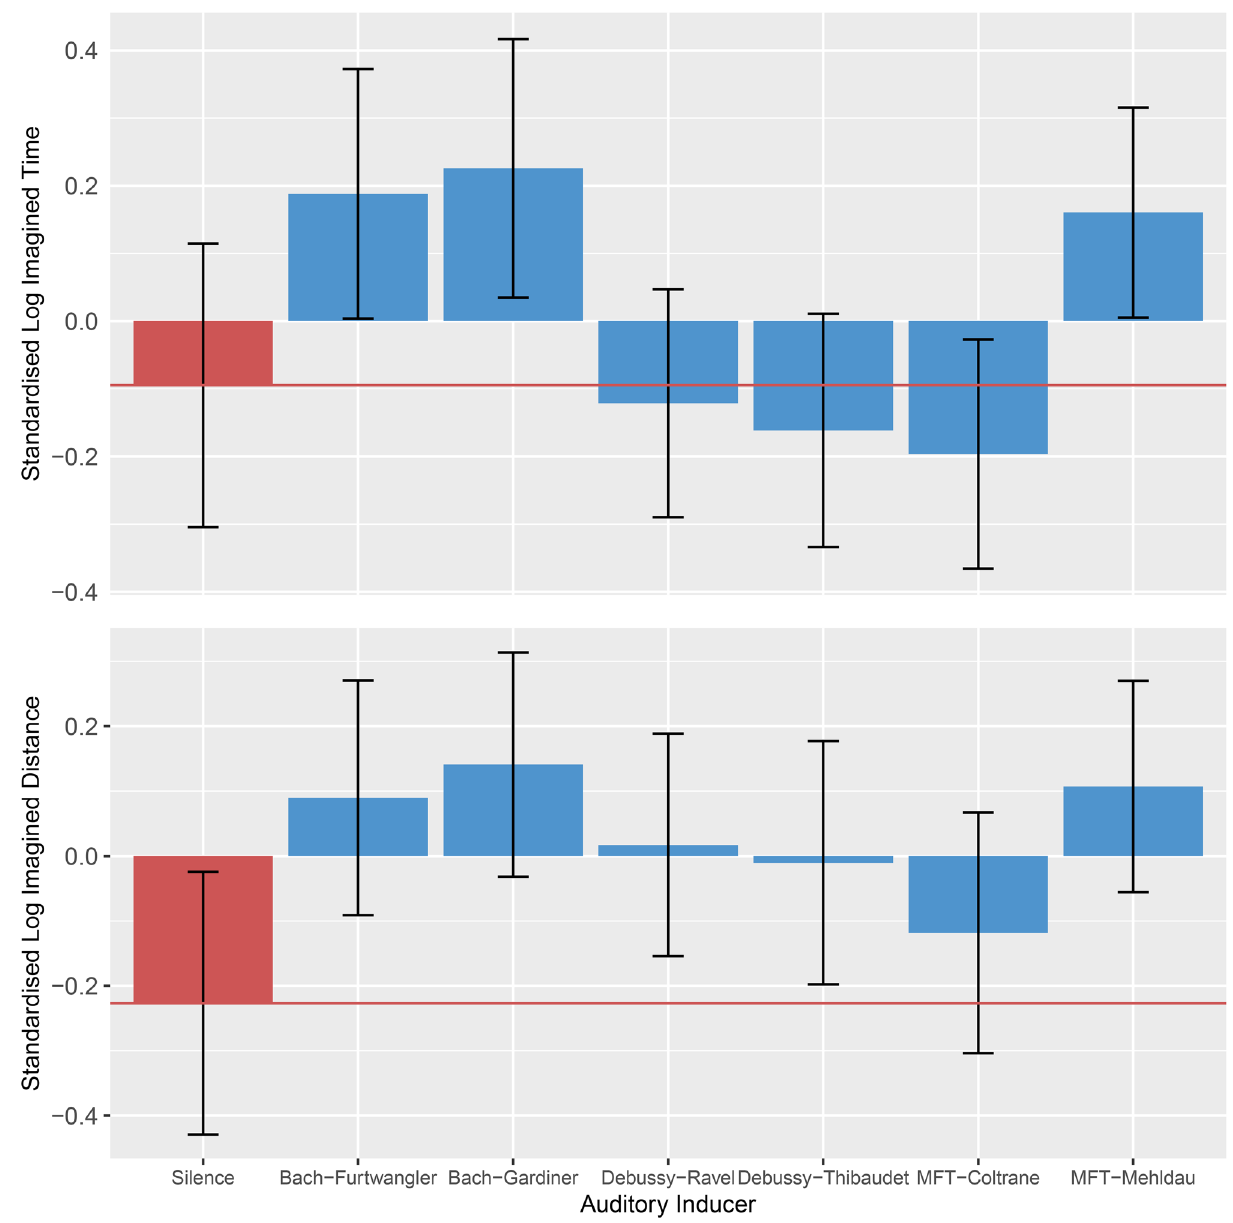
same inducer. For example, renditions of My Favorite Things by Coltrane and Mehldau induce different degrees of imagined distance as well as time. The red line indicates the mean of the silent control condition. Error bars show 95%